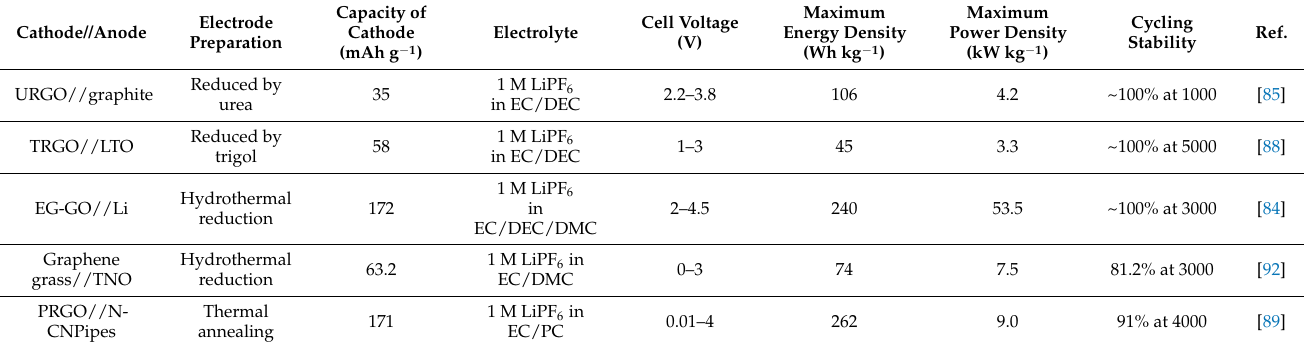
Table 2. Properties of reduced graphene oxide cathode and the performances of